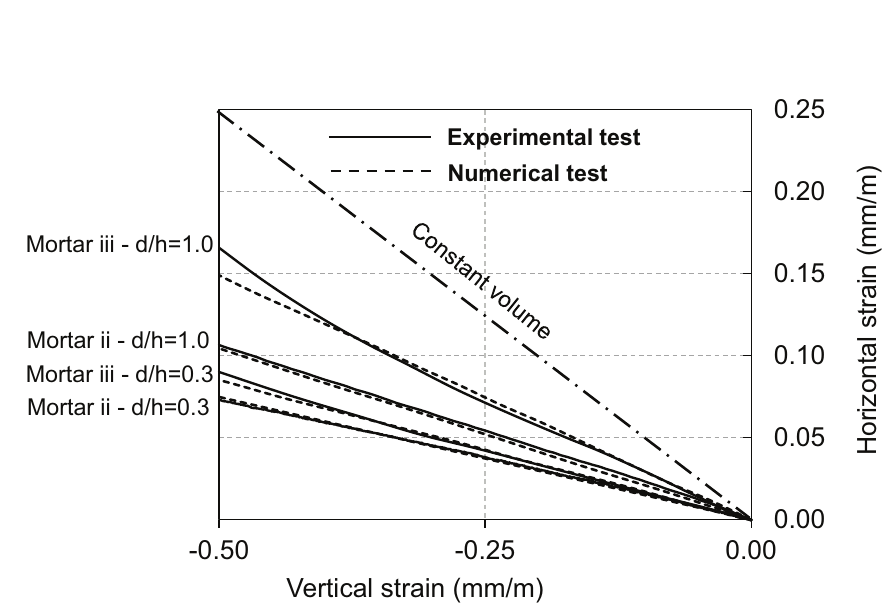
Vertical and horizontal strains of the numerical and experimental